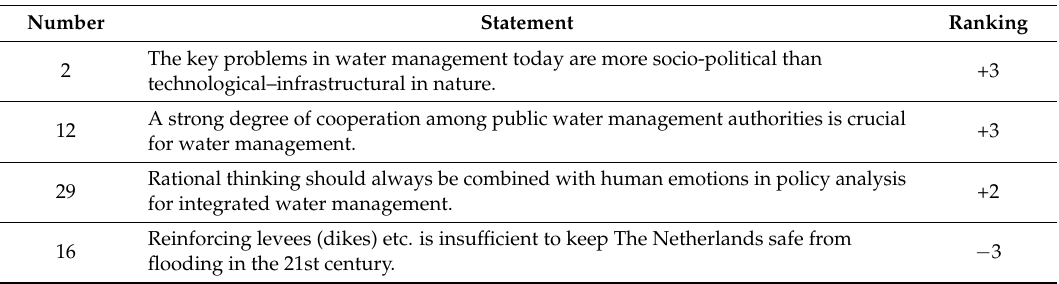
Table 9. Distinguished statements about IWRM in frame